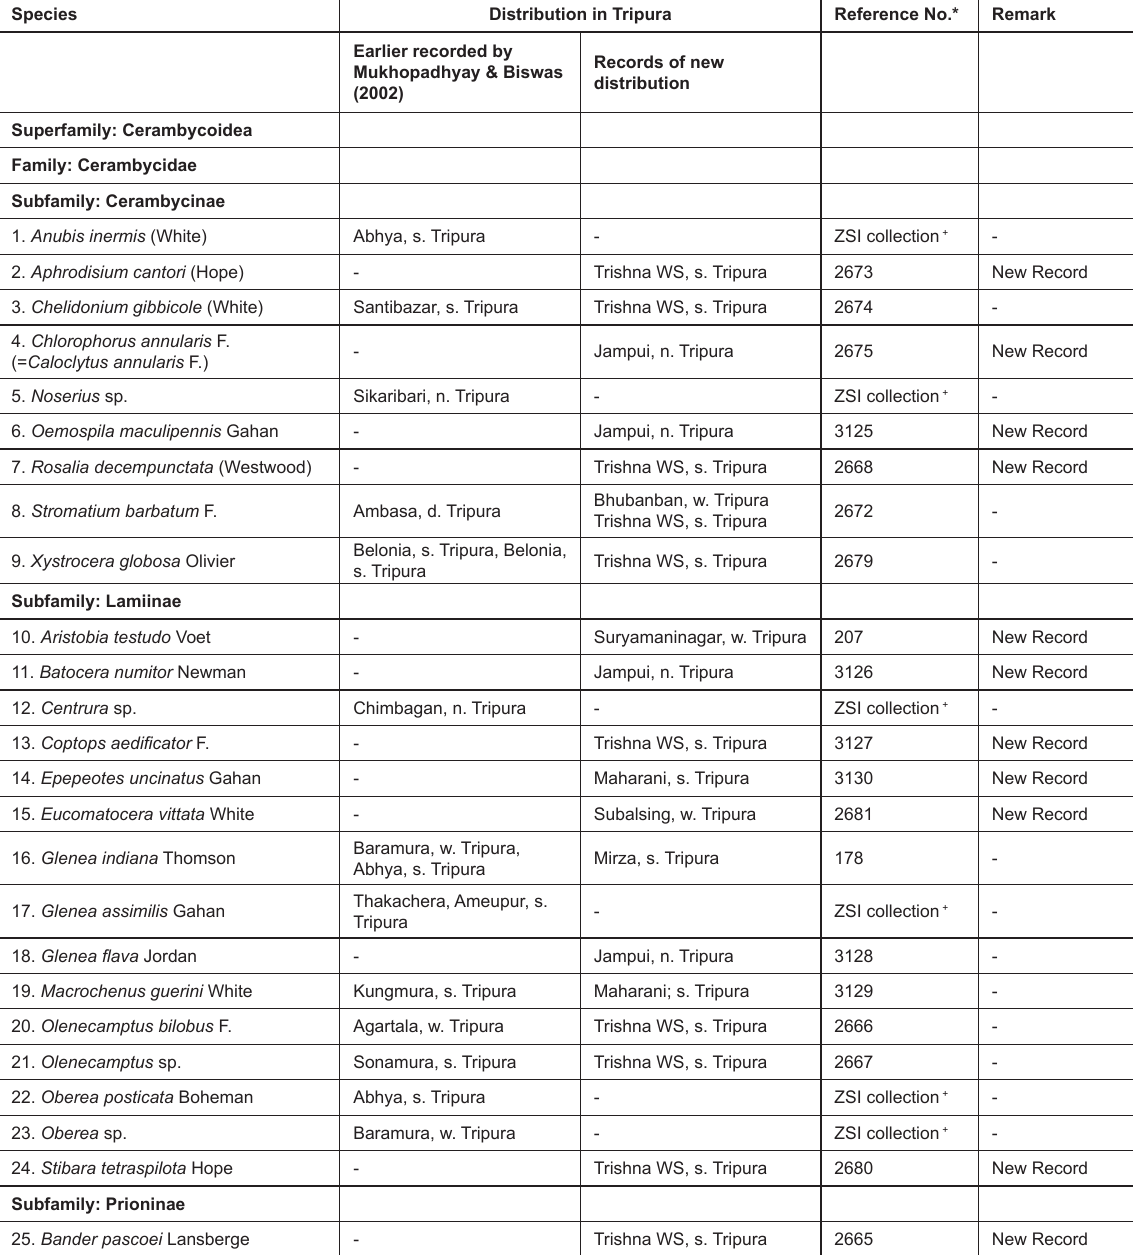
Table 1. Records of Cerambycidae beetles of Tripura